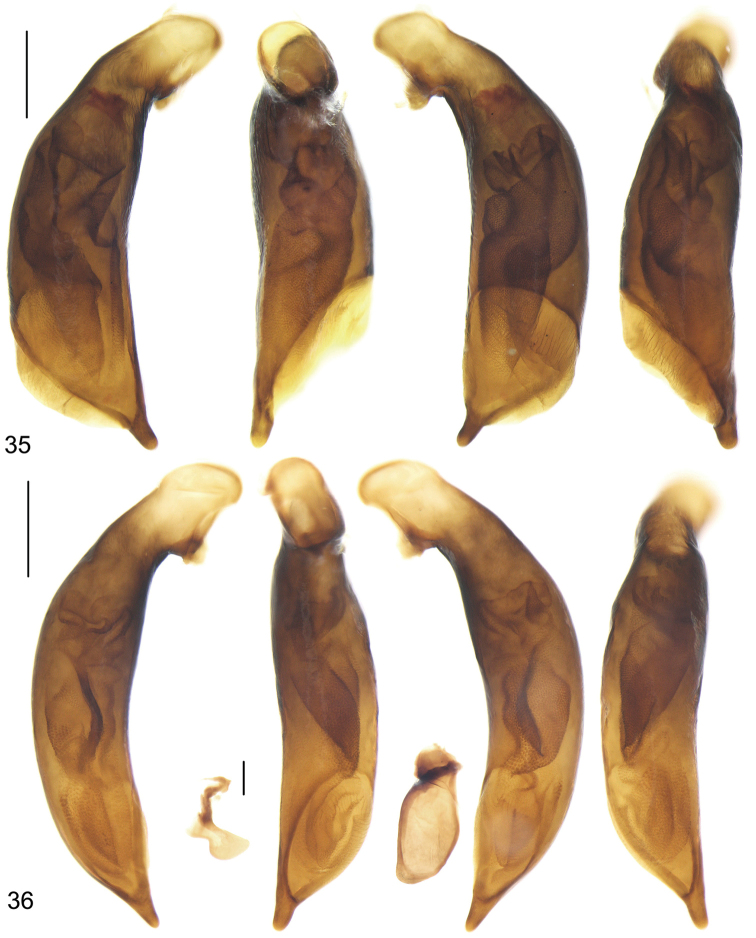
Aedeagus: right-lateral, ventral, left-lateral, and dorsal views of median lobe, scale bars 0.5 mm. Right and left parameres, scale bar 0.2 mm. 35
P.
obtusipennis Fedorenko, Yunnan (Pianma) 36
P.
obscuratus sp. n., holotype, Guizhou (Fanjingshan).